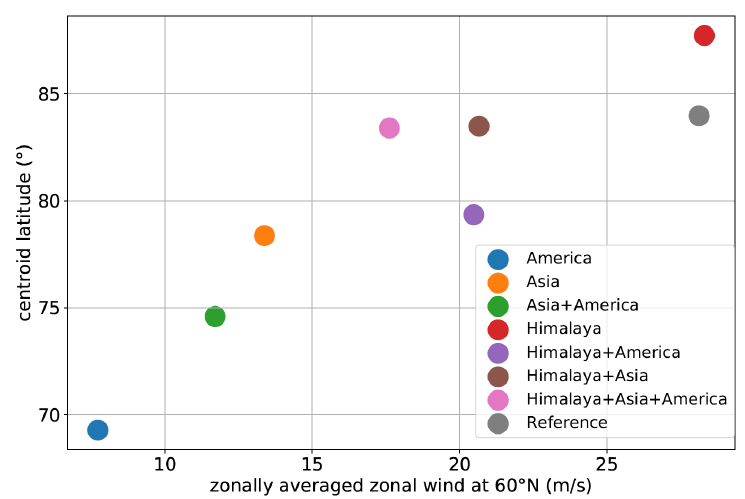
Figure A2. Position of the polar vortex based on the centroid latitude (according to Matthewman et al. [65], Seviour et al. [66]) in relation to the changes in wind speed for each experiment at an altitude of